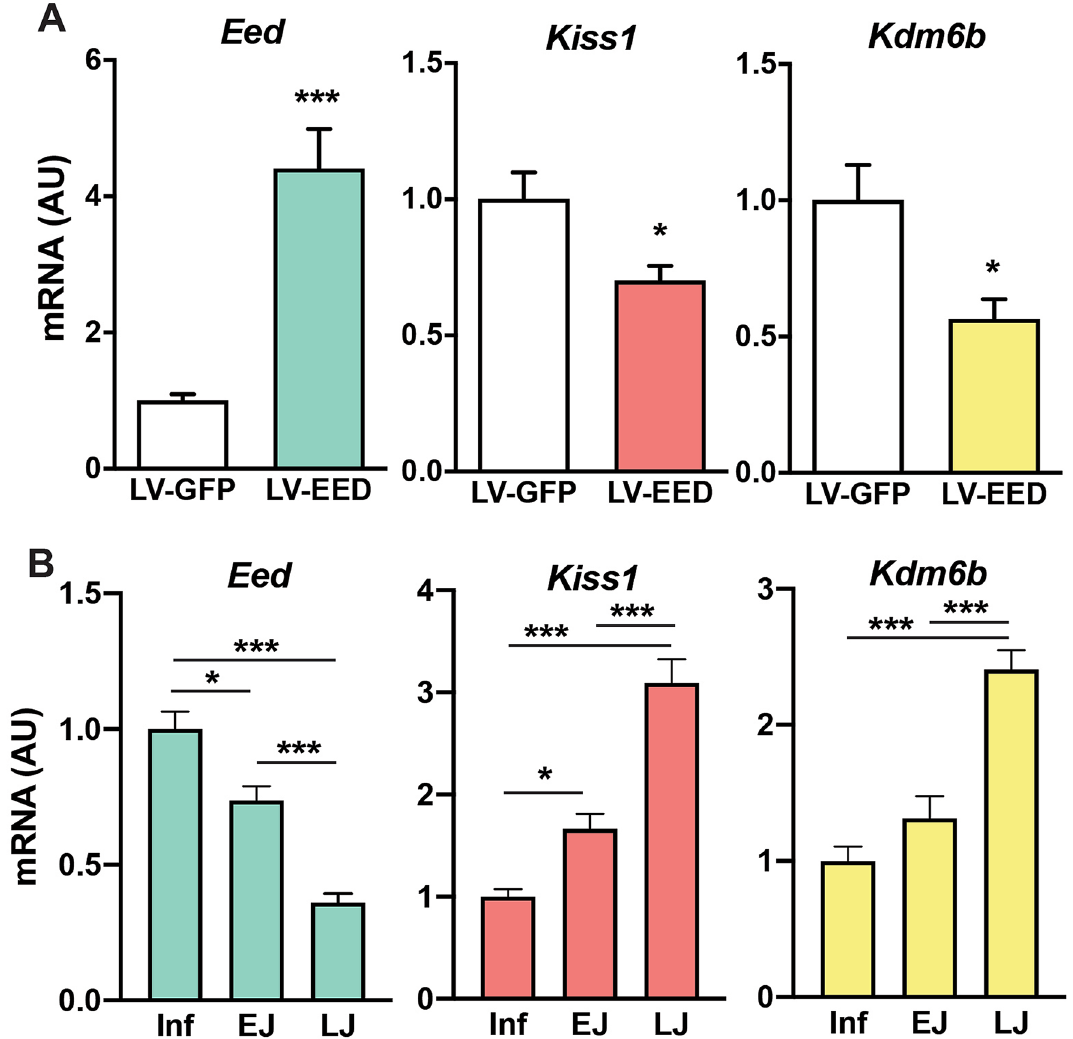
Figure 4. Changes in MBH gene expression elicited by EED overexpression or during prepubertal development. ( A ) The animals received a bilateral injection of LV-GFP or LV-EED in the ARC at the beginning of juvenile development (22-days of age), and the MBH was collected on postnatal day 28; mRNA levels were measured by qPCR. Results are expressed as fold change with respect to control values. *p < 0.05, ***p < 0.001 vs. LV-GFP- Control treated rats. (Student’s t-test) (n = 8 per group). ( B ) Rats were euthanized at 3 different stages: Inf; infantile (14 days of age), EJ: early juvenile (21 days of age) and LJ: late juvenile (28d of age) of prepubertal development. MBH was collected to determine mRNA levels by qPCR. Results are expressed as fold change with respect to Inf values. *p < 0.05, ***p < 0.001, One Way ANOVA followed by Student–Newman–Keuls Test (n = 6 per